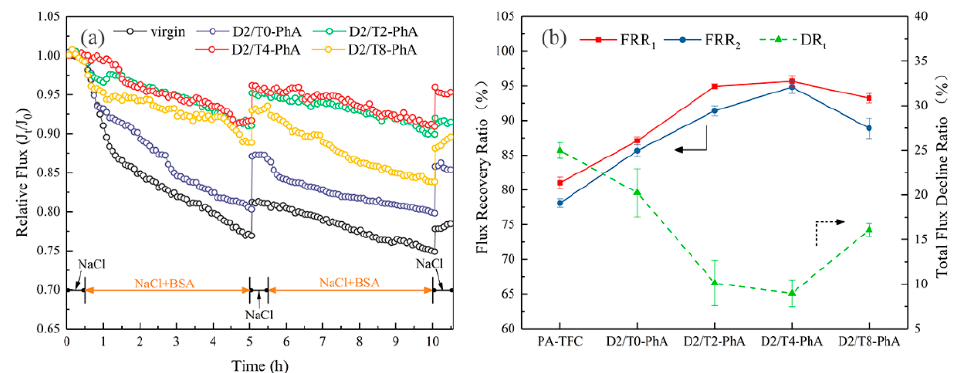
Figure 5. ( a ) Time-dependent relative water flux and ( b ) FRR i values and DR t values of PA-TFC and DA/TA-PhA membranes tested with 2000 mg · L − 1 NaCl and 100 mg · L − 1 BSA aqueous